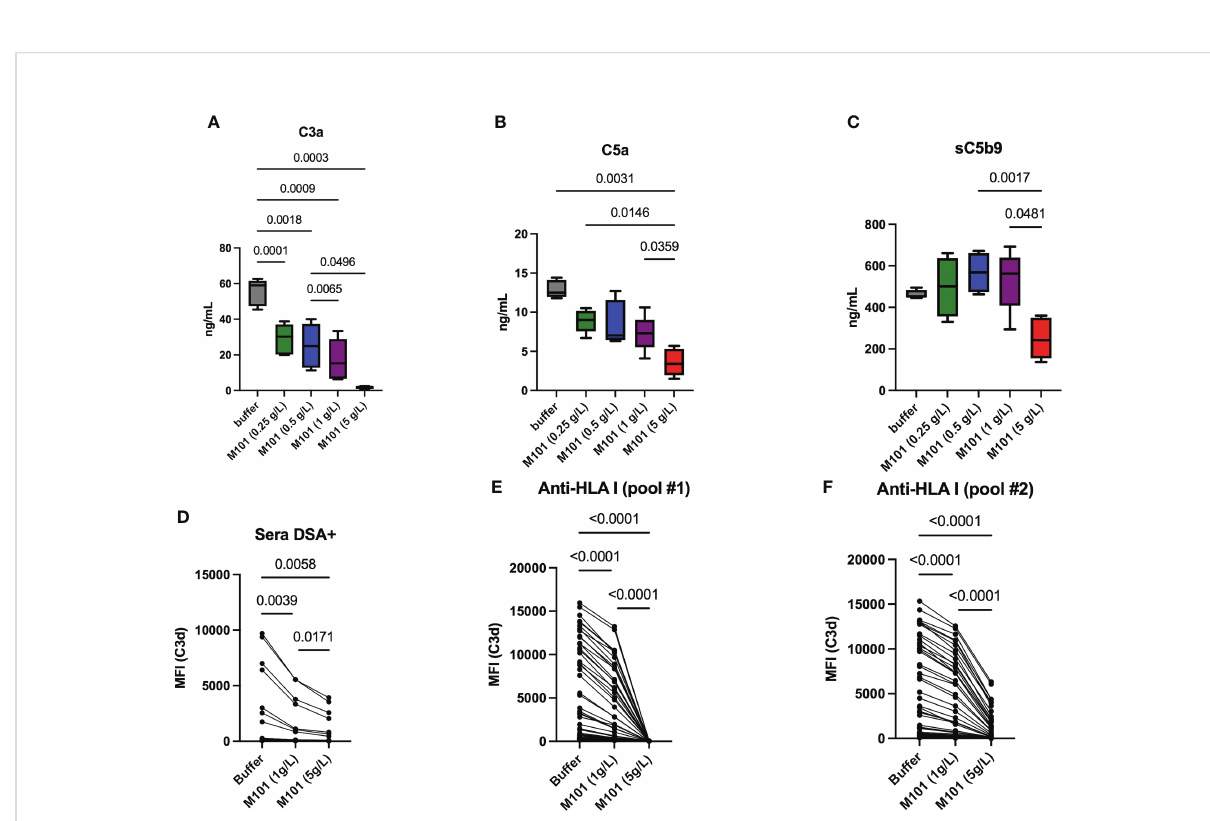
FIGURE 5 M101 inhibits C3 convertase. (A – C) C3 convertase activation and capacity to produce C3a (A) , downstream C5a (B) , and fi nally sC5b-9 (C) was evaluated by ELISA performed on supernatants collected after CH50 assay. EDTA-plasma (n=5 healthy controls) was obtained from EDTA whole blood pre-incubated 6h with an increasing amount of M101 (buffer, 0.25 g/L, 0.5 g/L, 1 g/L, and 5 g/L). These pre-incubated plasmas were mixed with IgG-coated sheep blood cells in the CH50 assay and supernatants were collected after 7 mns (D – F) Capacity to release C3d in a Luminex assay using 96 HLA class-I beads in the presence of M101 (buffer, 1 g/L and 5 g/L), complement fractions, and patient sera containing C3d positive anti-human leukocyte antigen (HLA)-I antibodies from one patient (D) or from a pool of patients ( E : pool #1; F : pool #2). Results from the 96 HLA class-I beads are represented. The median fl uorescence intensity (MFI) for each HLA class-I speci fi city is reported. P values are indicated when signi fi cant